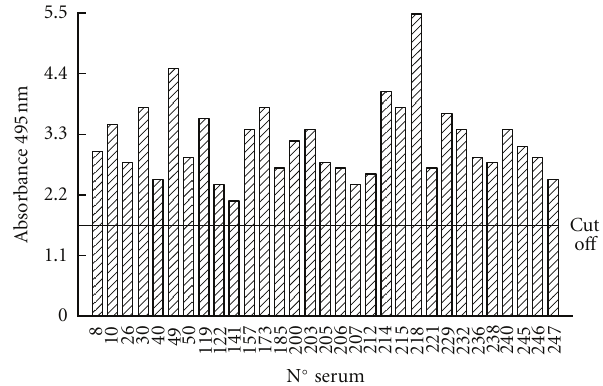
Figure 2: Results of the assay of 258 serum samples from human, collected in the suburban population of Quer´etaro city (Mexico) by enzyme-linked immunosorbent assay using the Fe-SODe by T. cruzi , as antigen at a dilution of 1/100. The mean and standard deviation of the optical densities of the control sera were used to calculate the cut-o ff value (mean × 3 standard